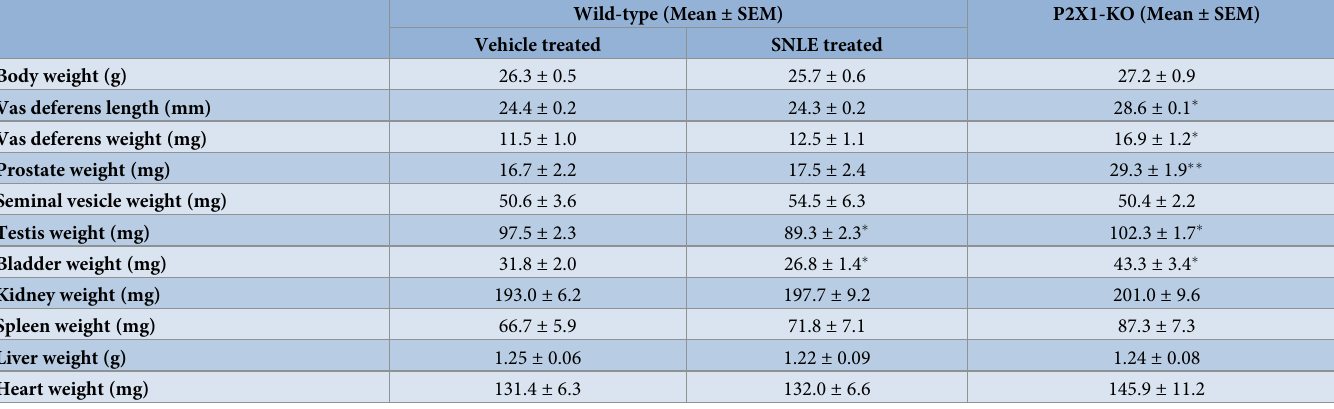
Table 1. Mean body and tissue weights or lengths in age-matched vehicle and stinging nettle leaf extract (SNLE) treated wild-type and P2X1-purinoceptor knockout (KO)